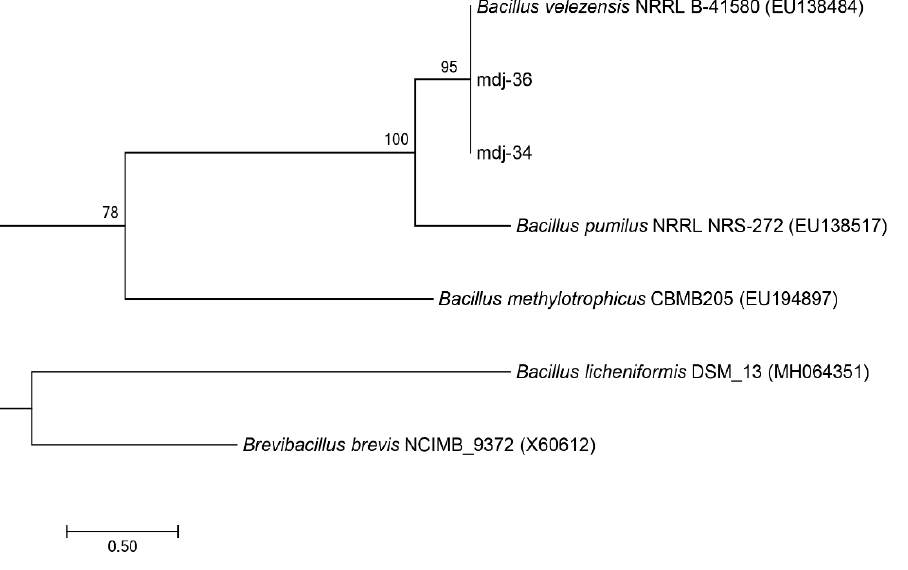
Figure 2. Efficacy evaluation of antagonistic B. velezensis mdj-36 against Fusarium oxysporum -induced rice seedling blight for ten days. ( A ) incidence, and ( B ) control efficiency. All values were expressed as mean ± SD. Varying significant differences were noticed between tested strains ( p < 0.05). 3.4. Metabolomics Characteristics of All Samples Principal-component analysis (PCA) and partial least squares discriminant analysis (PLS-DA) of the 12 analyzed samples ’ metabolomics profiles were conducted to provide information on the differences between B. velezensis mdj-36 and mdj-34 growth media. As shown in Figure 3, PCA analysis of metabolites determined through LC-MS (+) and LC- MS (−) found significant differences in mdj -36 and mdj-34 growth media ’ s metabolic compositions. This observation was consistent with the PLS-DA analysis.